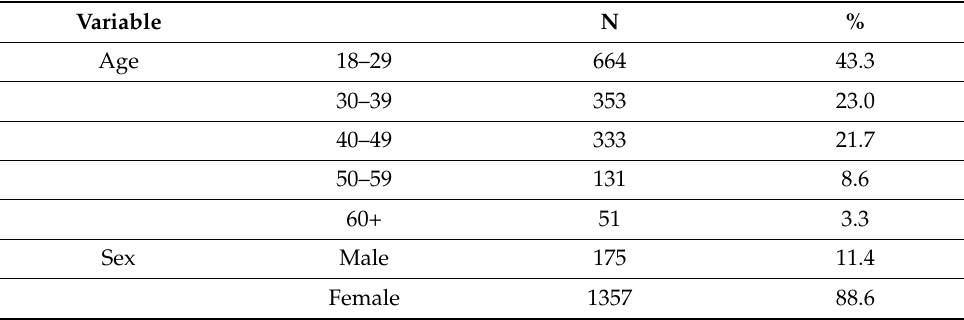
Table 1. Demographic characteristics of studied